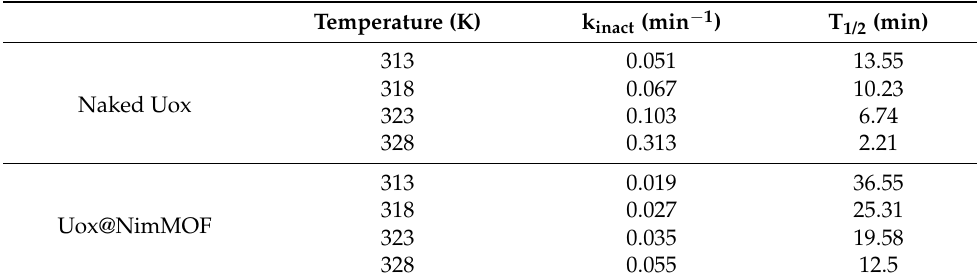
Table 1. Thermal inactivation parameters for Uox and Uox@NimMOF.